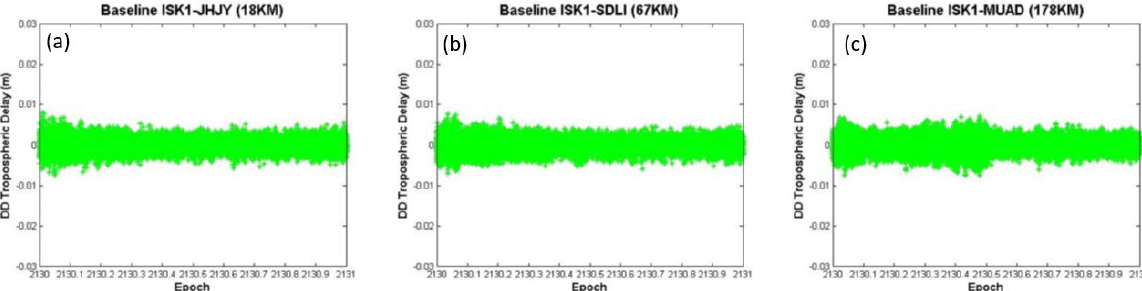
Figure 5. Non-dispersive medium of GPS distance-dependent errors for (a) short, (b) medium, and (c) long baselines.